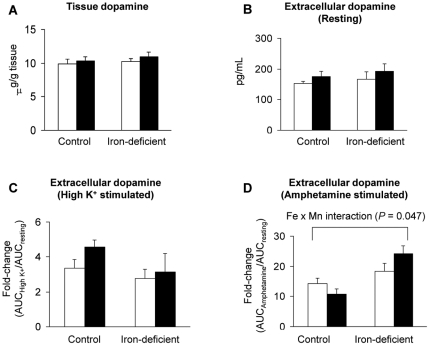
Effect of iron deficiency and manganese instillation on dopamine turnover in the striatum.Immediately after rotarod test (
Fig. 3
), rats were euthanized and striatal tissues were homogenized to determine the tissue concentrations of dopamine (A; N = 3–4). Rats of another cohort were anesthetized with urethane and microdialysis was performed to determine the basal dopamine concentration at resting state (B; N = 6–8) and the fold-change in AUC of dopamine release either after high K+ (30 mM) stimulation (C; N = 6–8) or after amphetamine stimulation (1 mg/kg, s.c.) in striatal extracellular fluid (D; N = 6–8). Empty and closed bars represent water-instilled and MnCl2-instilled rats, respectively. Data were presented as mean ± SEM and were analyzed using two-way ANOVA.